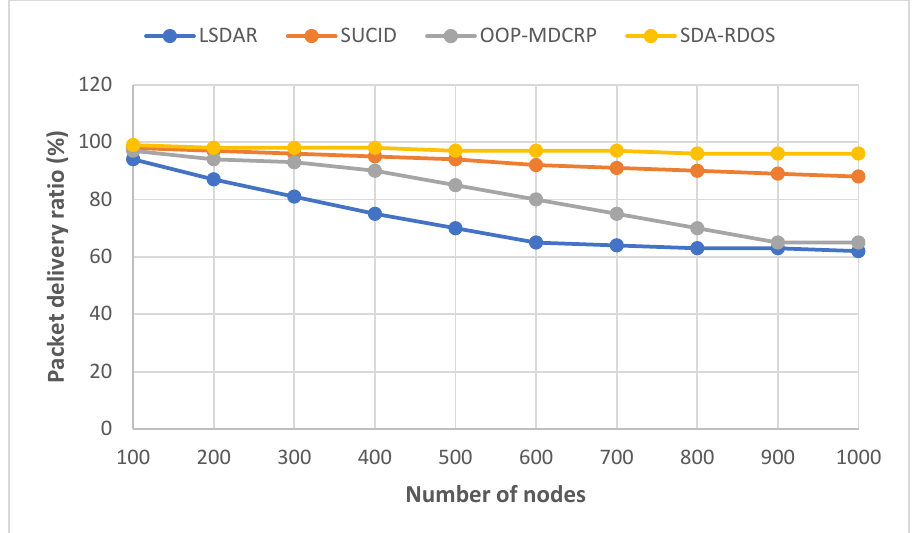
24 of 29 Figure 18. Average Delay Analysis of LSDAR, SUCID, OOP ‐ MDCRP, and SDA ‐ RDOS protocols. The cluster head receives the encrypted data from the member nodes in data cluster ‐ ing operations. The cluster head decrypts encrypted data. After data are collected/cen ‐ tered, they are encrypted again to be sent to the base station. Data privacy is violated in these transactions, and network delay occurs due to encryption/decryption processes. In the study carried out, because the RSA Homomorphic method is used, the data sent by the cluster member nodes are collected/averaged by the cluster head and transmitted to the base station without decrypting them. Figure 18 shows that the protocol with the clos ‐ est values to the SDA ‐ RDOS protocol is the OOP ‐ MDCRP protocol. Other protocols gave